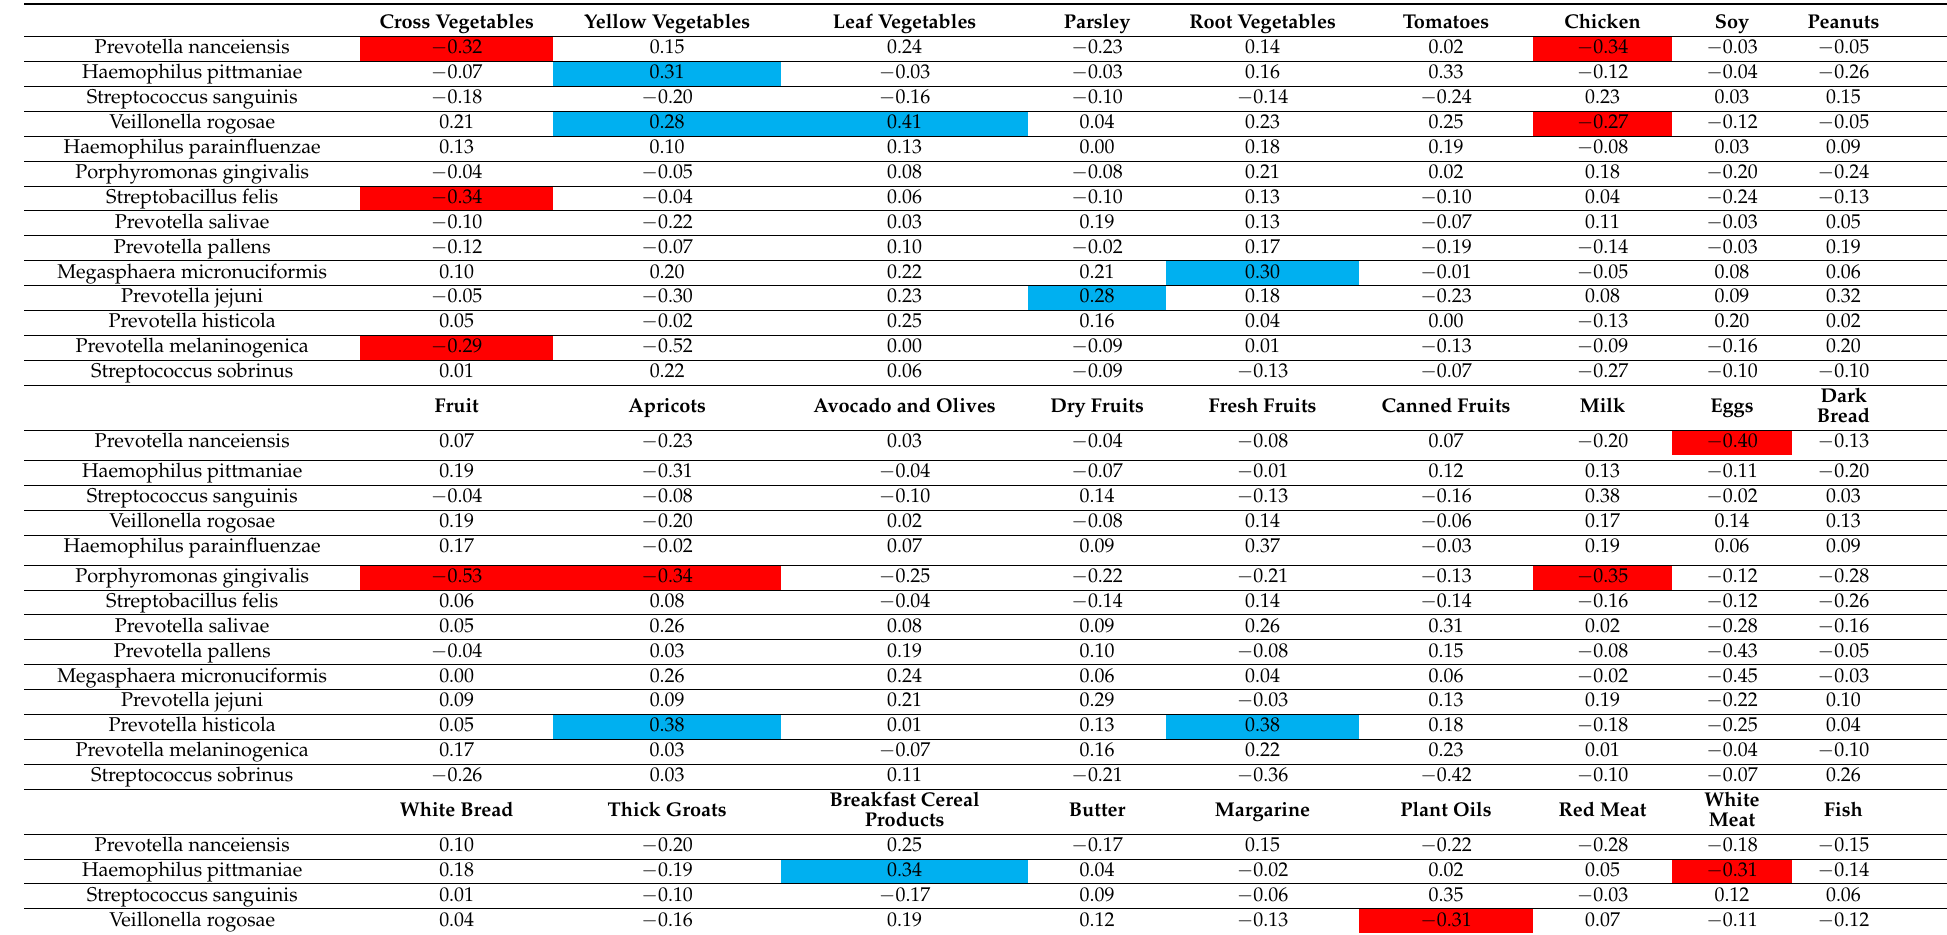
Table 5. The Pearson’s correlation values show the relationship between bacteria and the frequency of consuming particular food products. Blue color means the most potent positive correlations, while red means the most potent negative correlations. Cross Vegetables Yellow